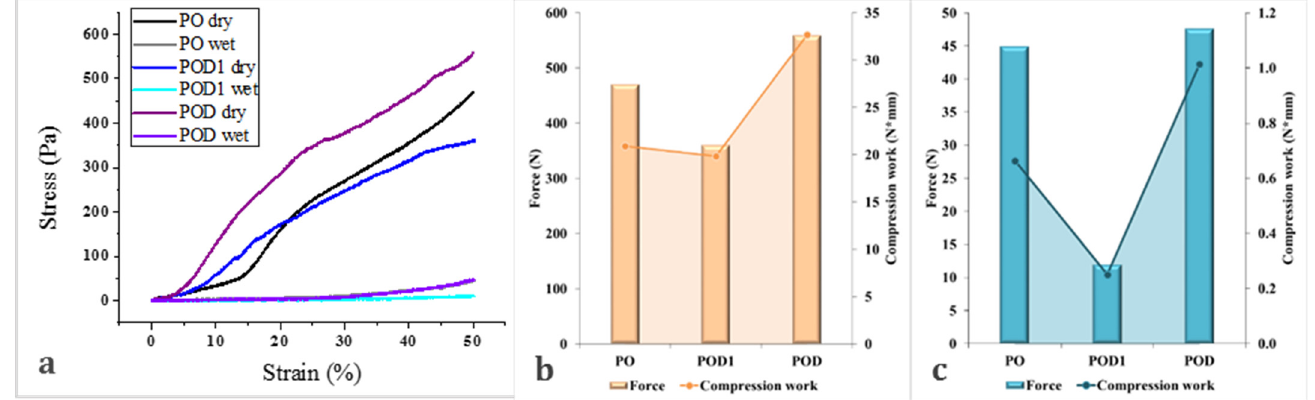
Figure 11. Mechanical properties of the cryogels: stress–strain curves ( a ) and illustration of the force and compression work for the materials in dry ( b , orange) and hydrated ( c , blue) states,